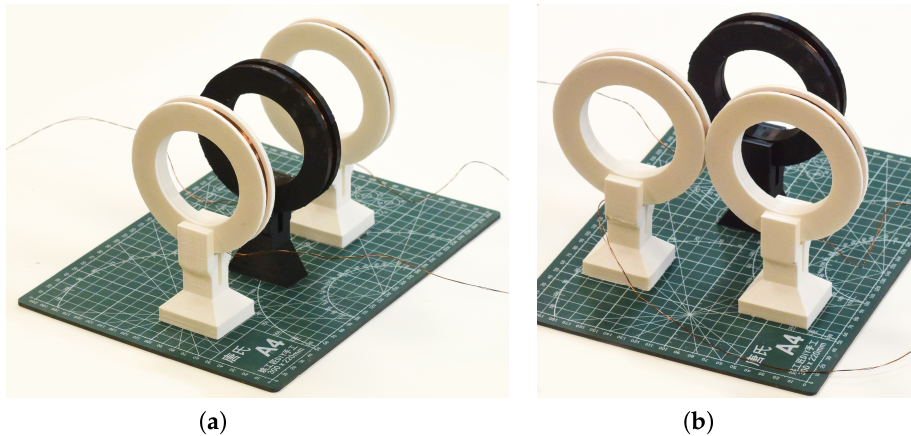
Figure 25. Coils setup: ( a ) in-line, as proposed in [8]; and ( b ) V-shape. The black coil is a transmitting coil, and the white coils are receiving coils.